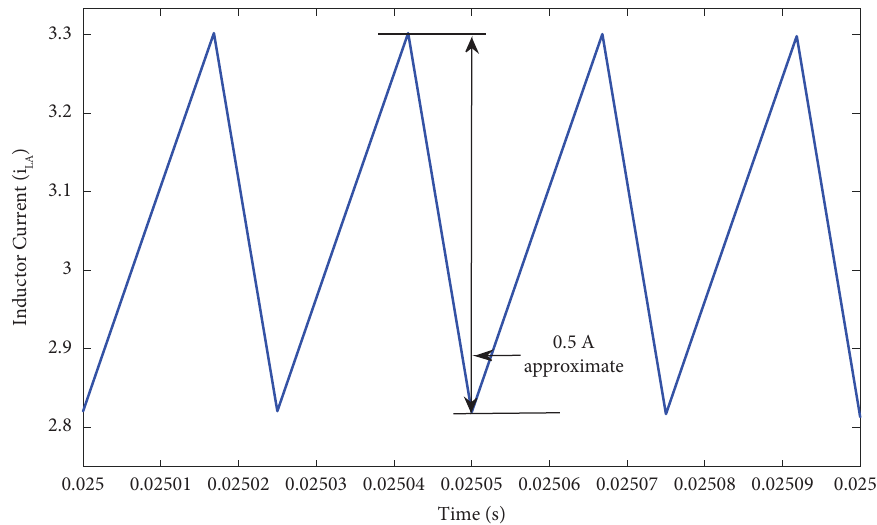
Figure 18: Te inductor L B simulated current waveform.